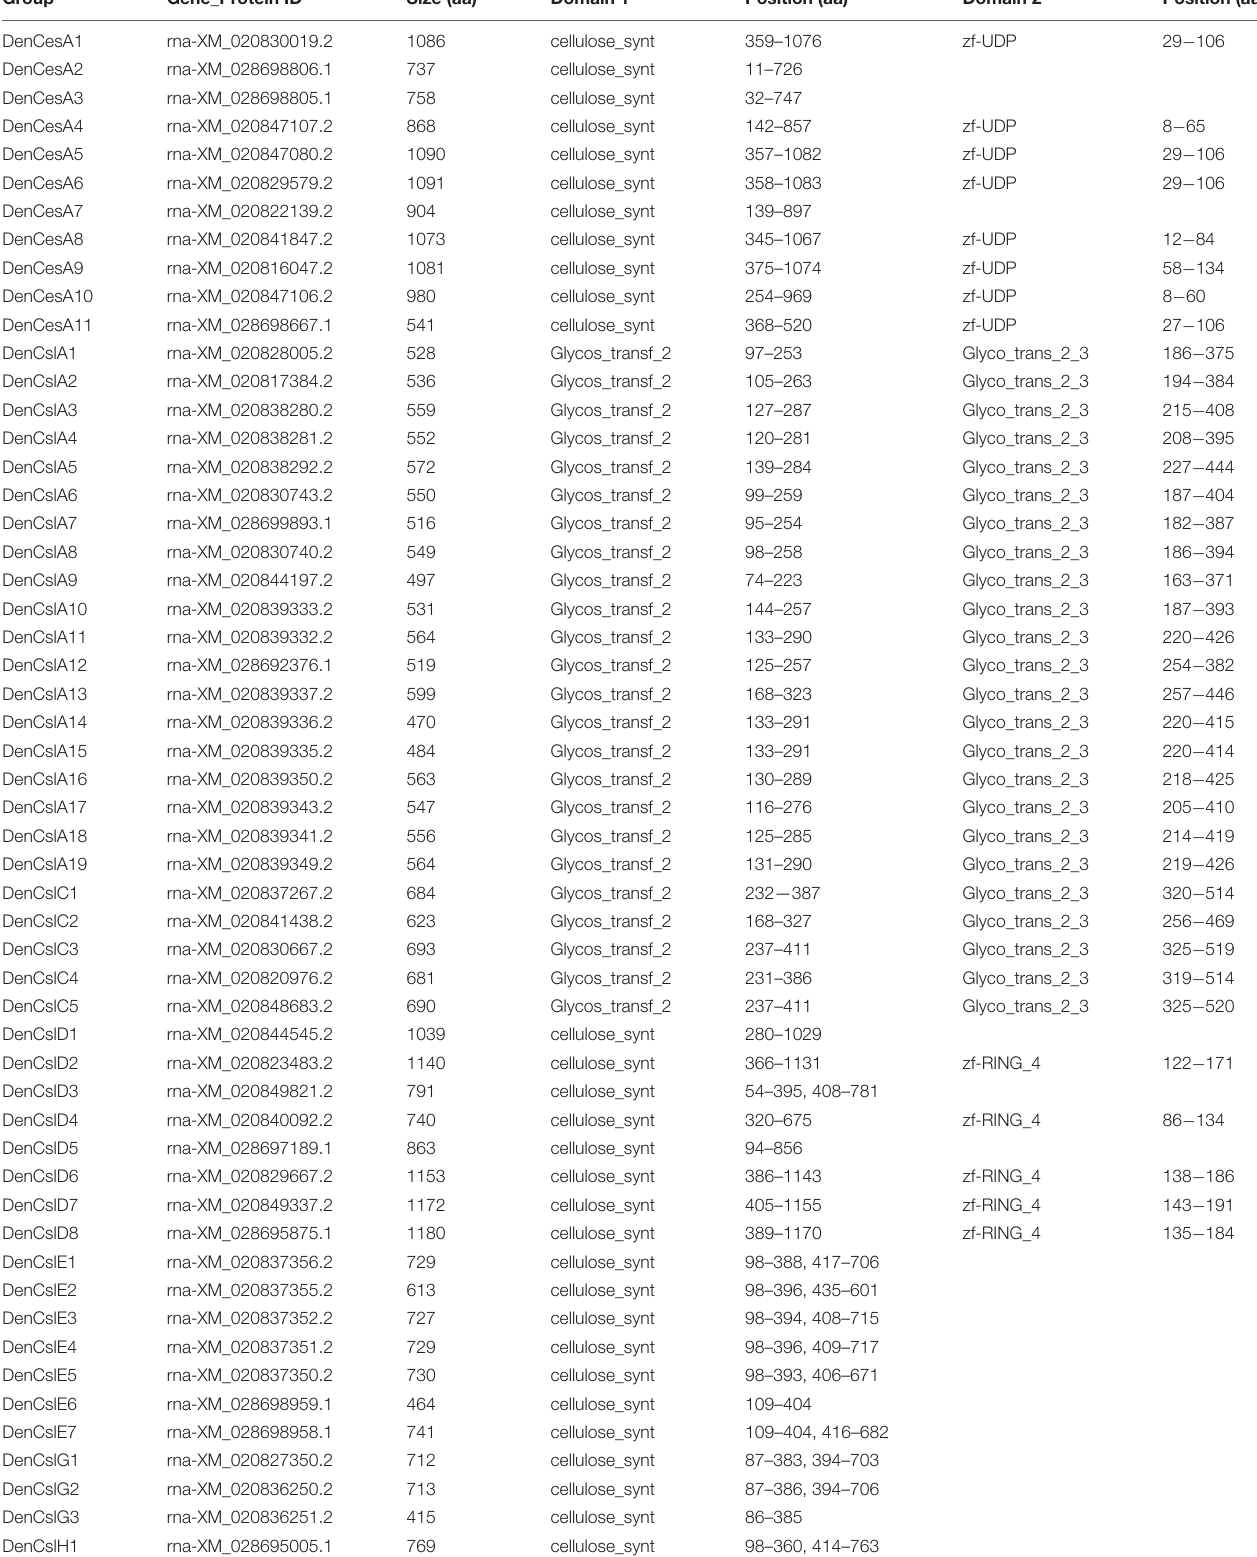
TABLE 2 | Structure of the Cellulose synthase proteins in D. officinale .